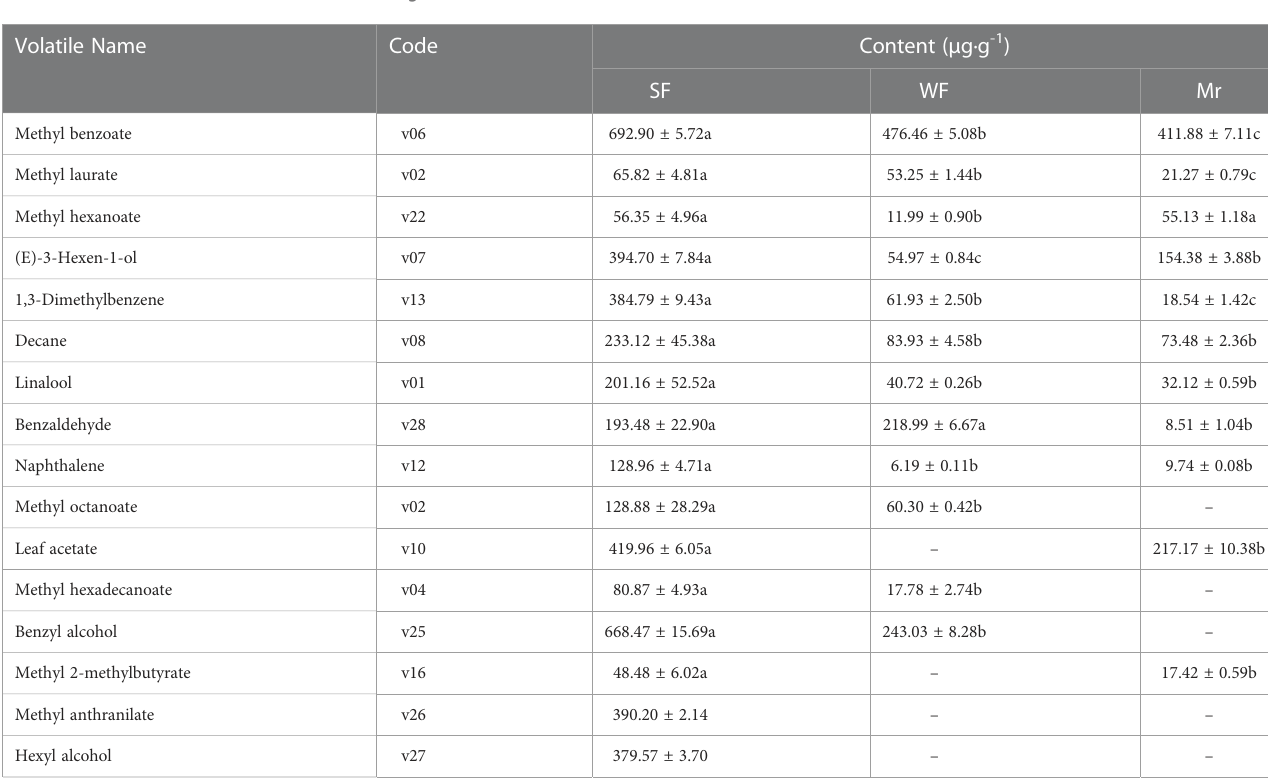
TABLE 1 Contents of fl oral volatiles at the ES